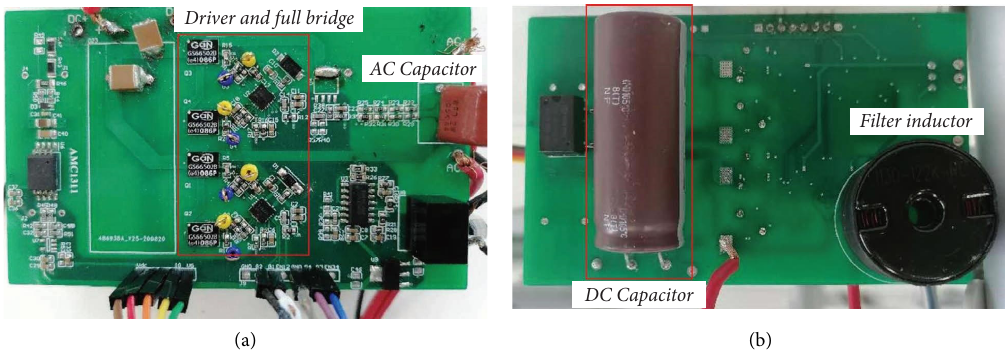
Figure 13: Te prototype of the single-phase VSI. (a) Top view. (b) Bottom